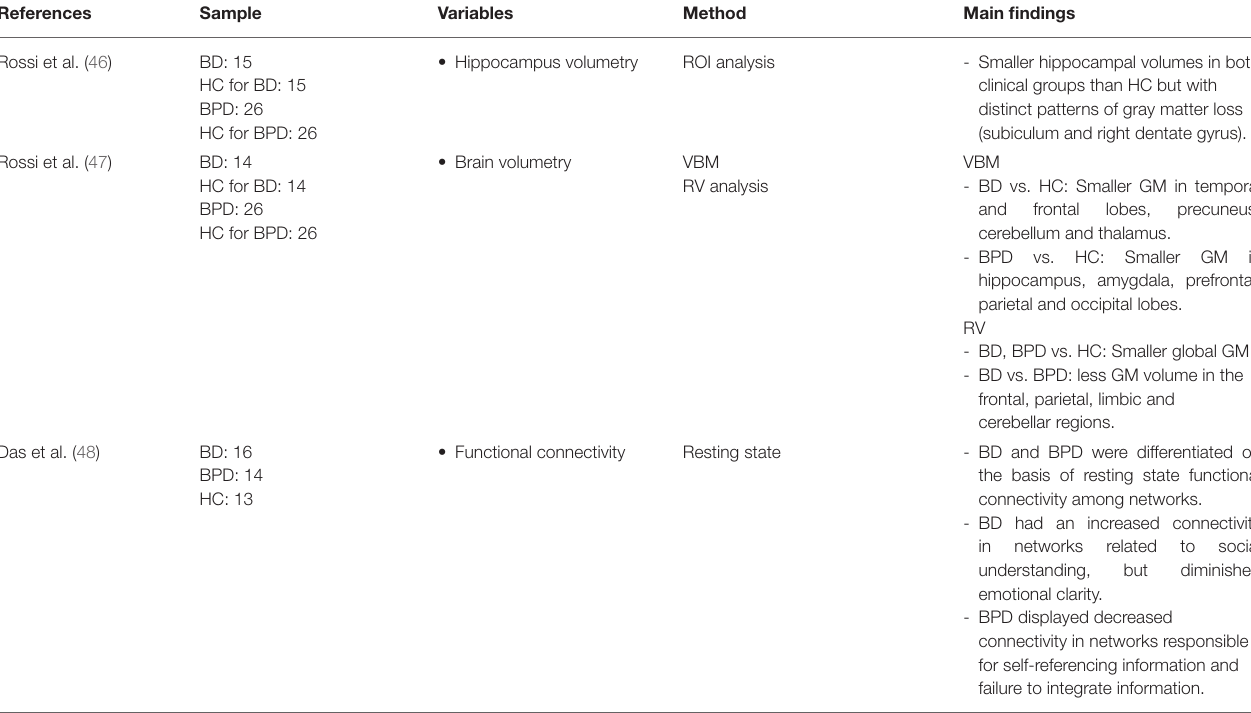
TABLE 3 | Neuroimaging results between bipolar disorder and borderline personality disorder.